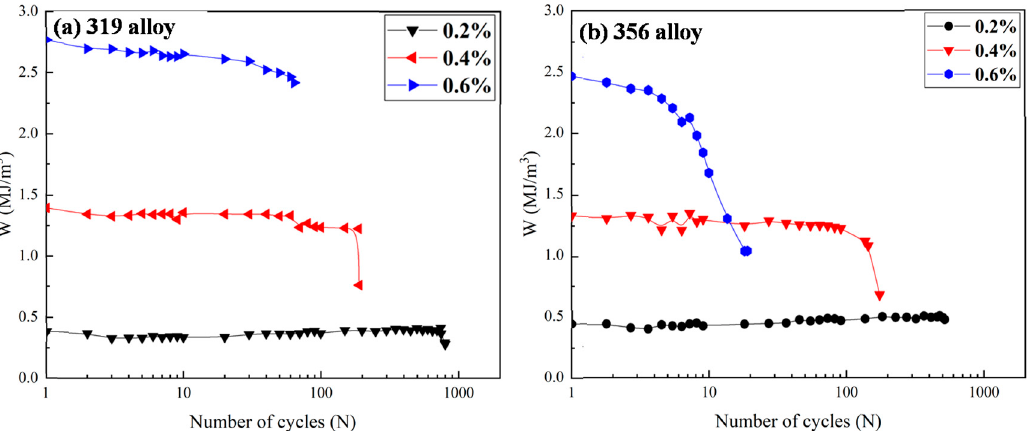
Figure 10. Evolution of hysteresis loop area ( W ) as a function of cycles for ( a ) 319 alloy and ( b ) 356 alloy.